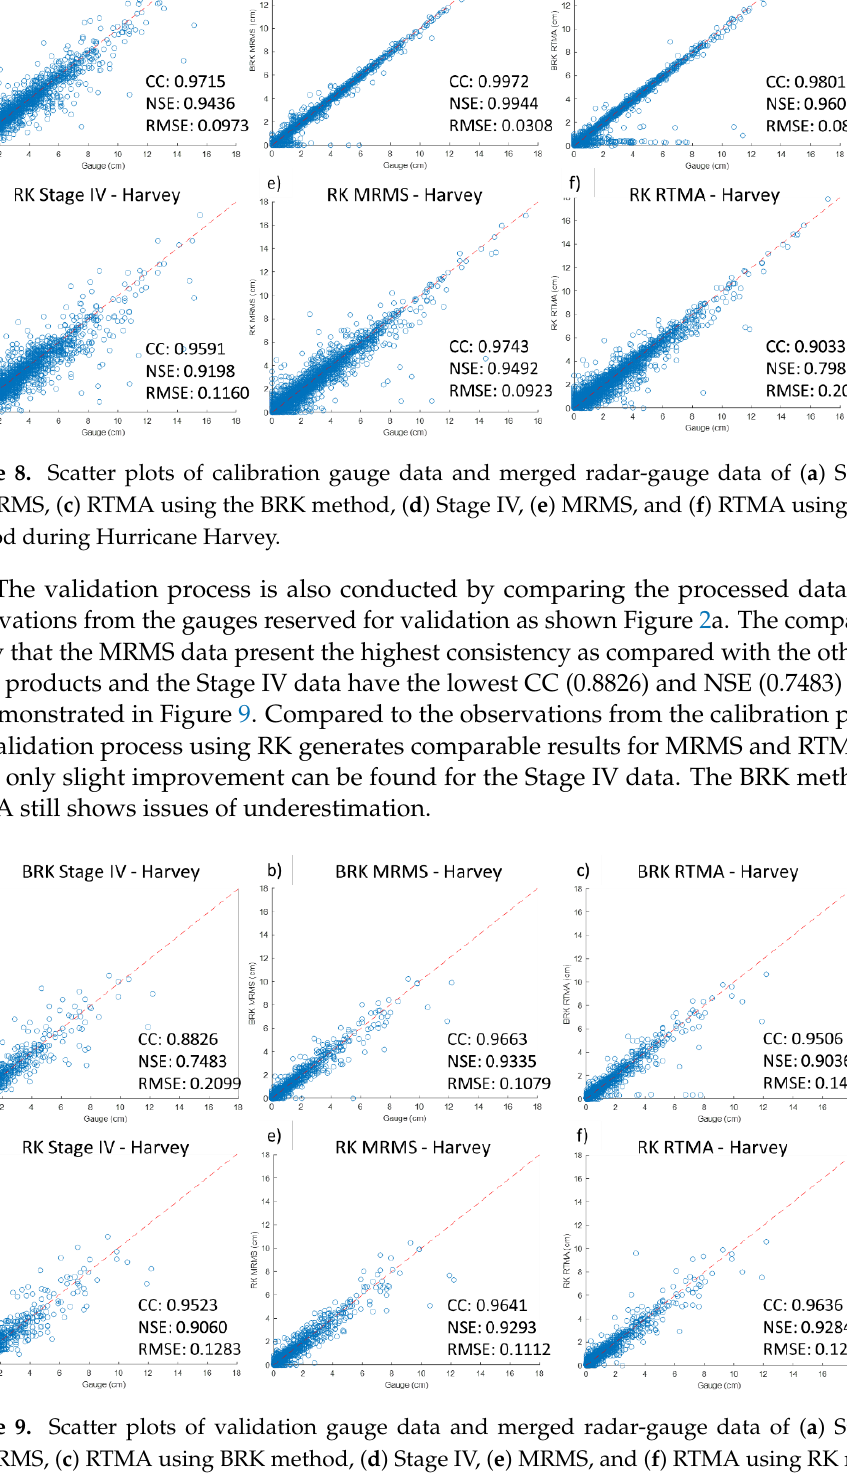
Figure 9. Scatter plots of validation gauge data and merged radar-gauge data of ( a ) Stage IV, ( b ) MRMS, ( c ) RTMA using BRK method, ( d ) Stage IV, ( e ) MRMS, and ( f ) RTMA using RK method during Hurricane